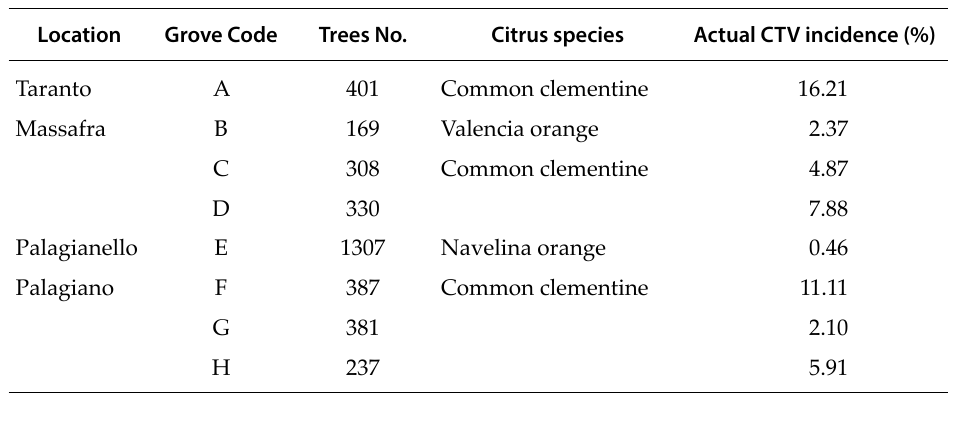
Table 1 . The actual incidence of Citrus tristeza virus (CTV) in eight groves (A-H) monitored in this study. CTV incidence was studied by sampling from all trees included in the study and individual testing by using Direct Tissue Blot Immunoassay (DTBIA).